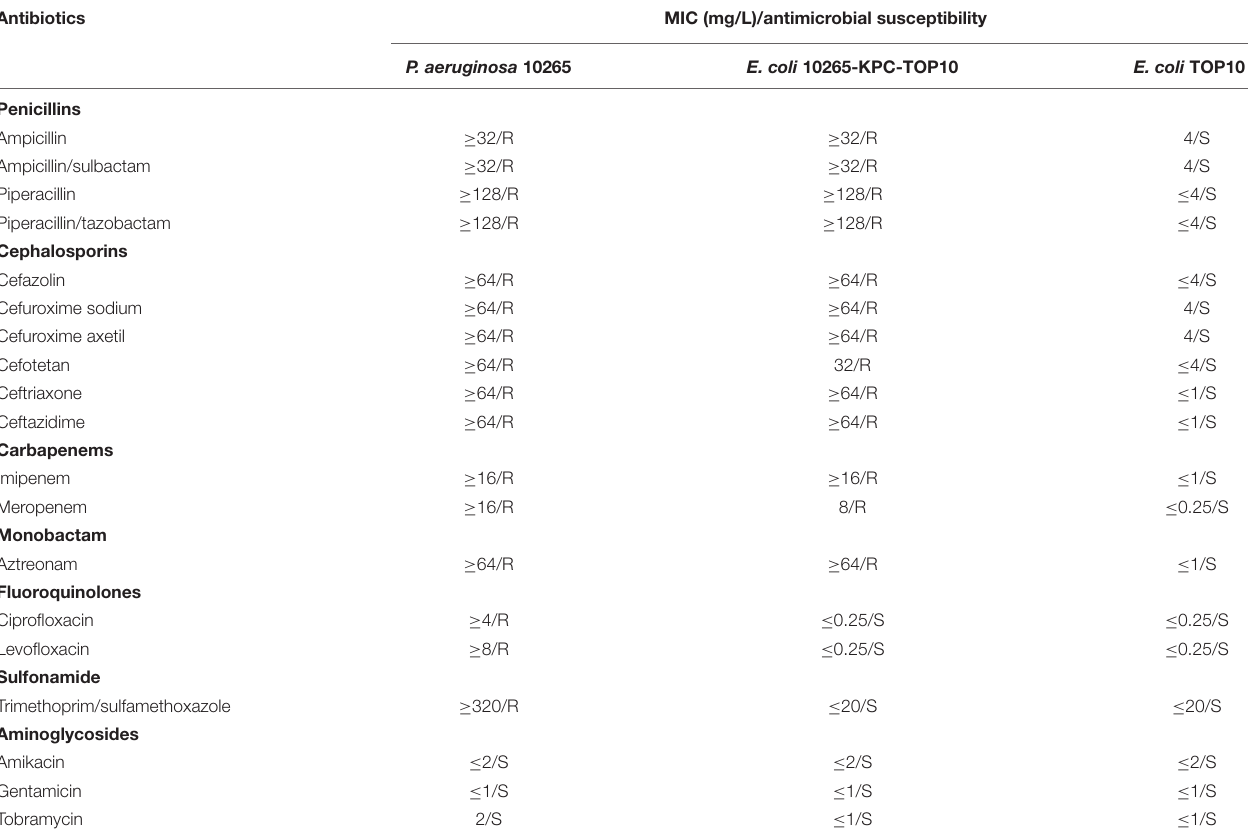
TABLE 1 | Antimicrobial resistance phenotypes of Pseudomonas aeruginosa and Escherichia coli with plasmid p10265-KPC. Antibiotics MIC (mg/L)/antimicrobial